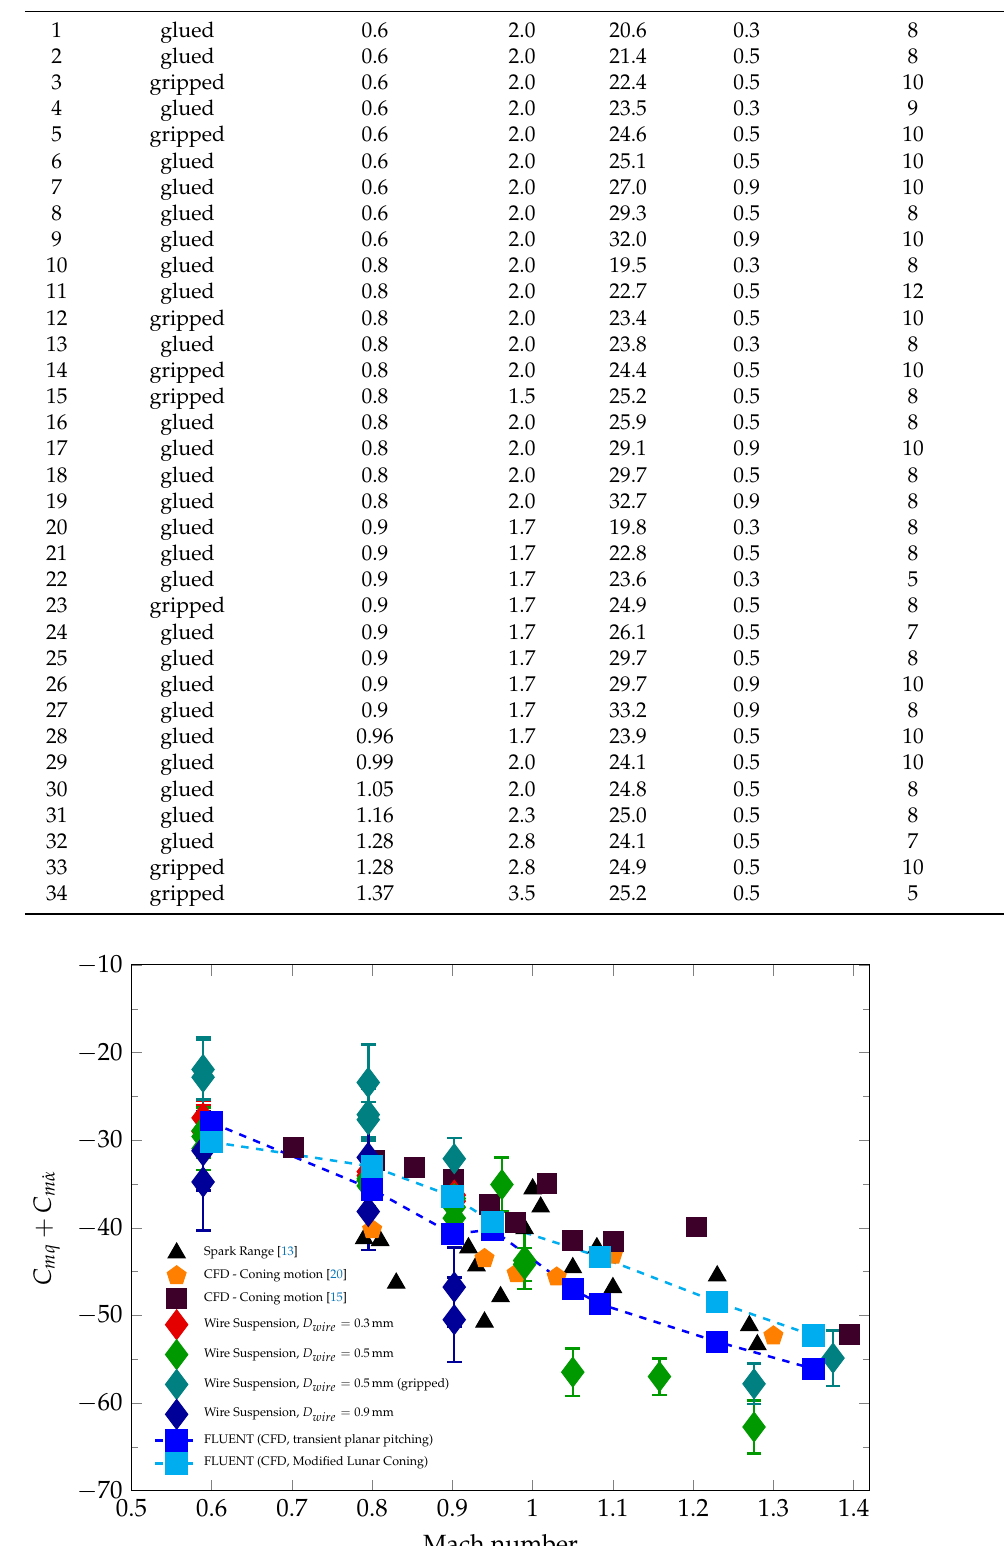
Figure 14. C mq + C m ˙ α over Mach number for the ANSR